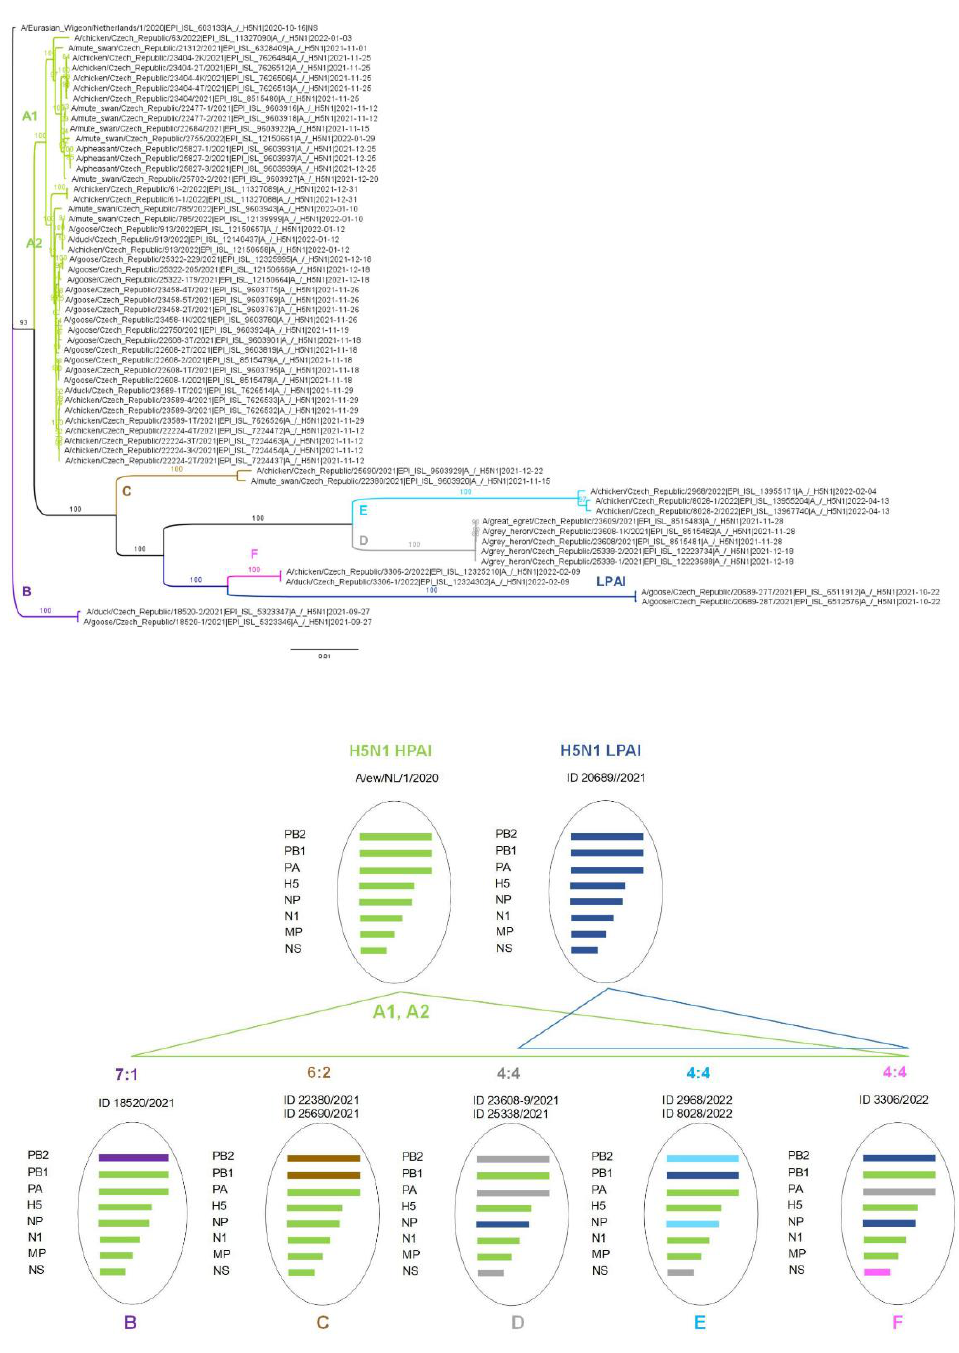
Figure 3. Genotyping of Czech H5N1 HP/LPAI strains detected during the 2021/2022 influenza sea- son. The ML tree was calculated based on 59 concatenated genomes and rooted to A/ew/NL/1/2020 H5N1. The order of segments in the concatenated genomes is PB2, PB1, PA, H5, NP, N1, MP, and NS. The tree was computed using IQ-TREE (GTR + F + R2 as the best-fitting model selected according to the Bayesian information criterion) and scaled with branch lengths measured in the number of substitutions per site. For each branch, bootstrap values (based on 1000 replicates) were given in percentages. Three branches corresponding to discrete genotypes were labeled as A–F and LPAI and highlighted with a genotype-specific color. Further, the figure summarizes the segment constellations of the identified influenza virus genomes inferred from SIMs, SDCMs, and phylogenetic trees calcu- lated individually for each segment (Supplementary Material file S1, Figure S1 and Supplementary Material file